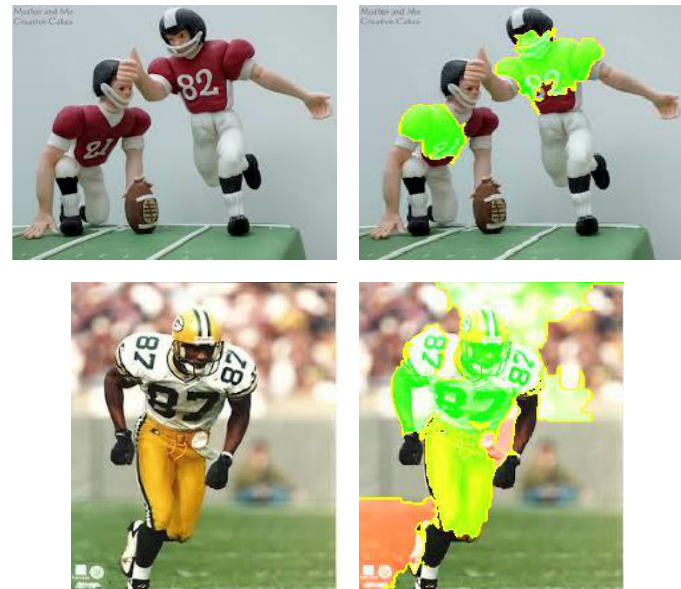
Figure 7. Examples of how LIME explained classifying images as American football. We can see that the equipment, such as helmets, visors, and shoulder pads, of athletes is decisive for